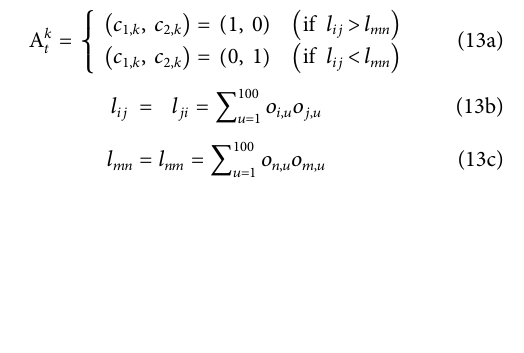
Figure 3. The bracing direction optimization formulation in Eqs 3a – ca – cEqs 3a – c allows only one brace in each grid cell. Therefore, l ij and l nm are compared to determine the bracing direction in a grid cell.